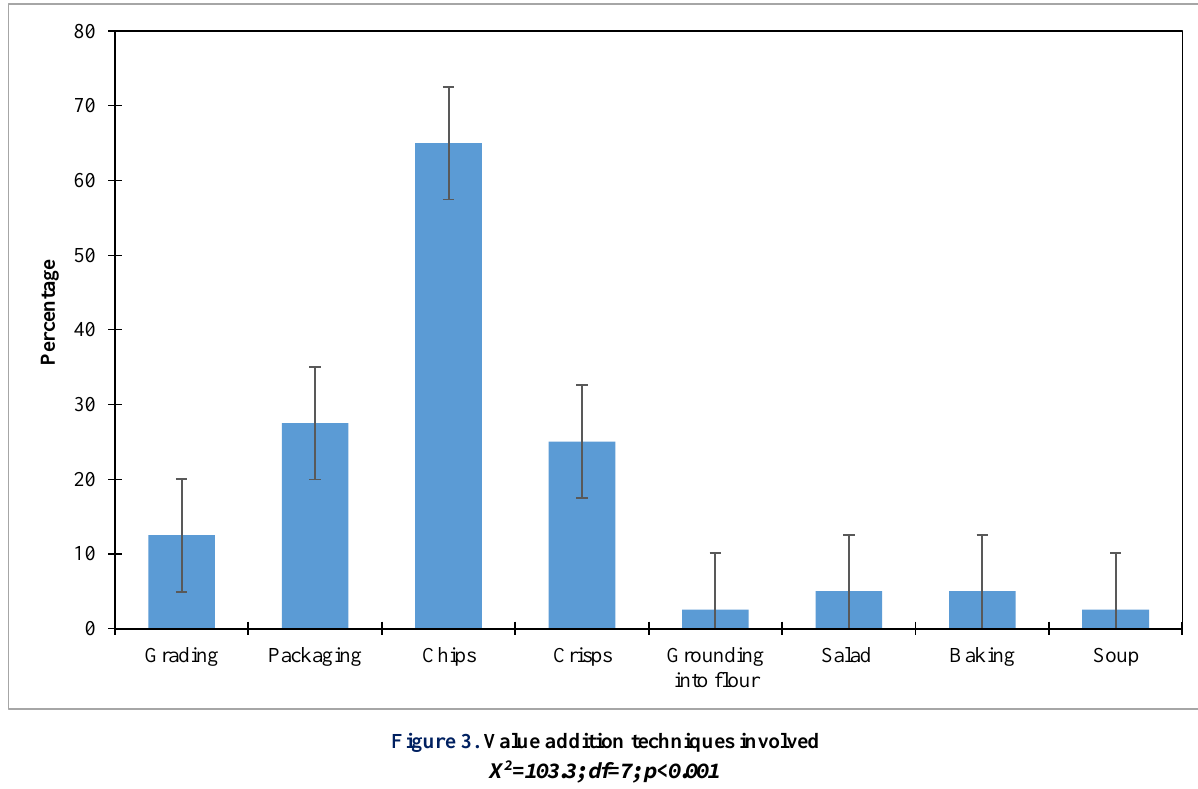
Figure 3. Value addition techniques involved X 2 =103.3; df=7; p<0.001